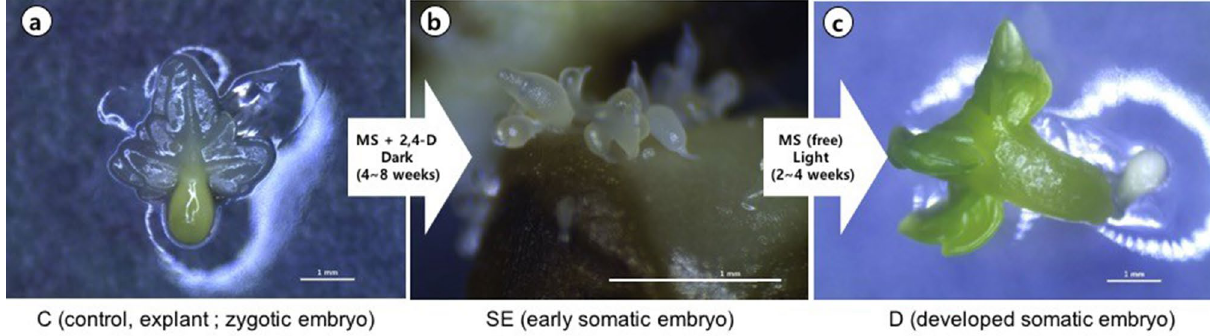
Figure 1. Photomicrographs of samples in stage C, SE, D. ( a ) stage C, zygotic embryo used as explant. ( b ) stage SE, directly induced early somatic embryo on the surface of explant. ( c ) stage D, matured somatic embryo. Scale bars, 1 mm. Captured by Nickon, SMZ745T.